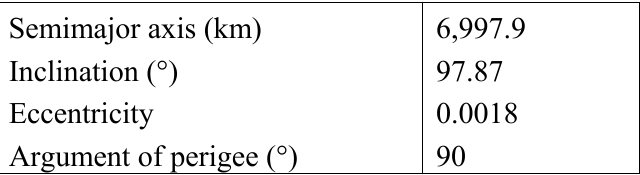
Table 1. Monostatic satellite orbital parameters [18, 19].